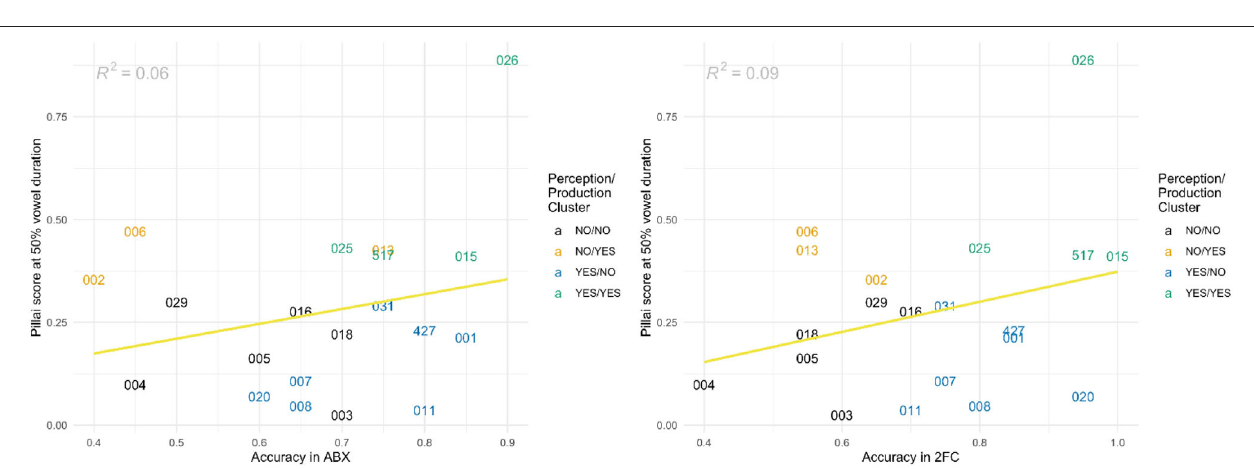
FIGURE 4 | Vowel plot for cot-caught productions with low vs. high Pillai scores. Vowel plot of individual tokens representative of the cot-caught contrast for Participant 003 (lowest Pillai score) and Participant 026 (highest Pillai score). Cot -words are graphed in black and caught -words in orange. Ovals indicate the 95% confidence interval (2 standard deviations) for each vowel.